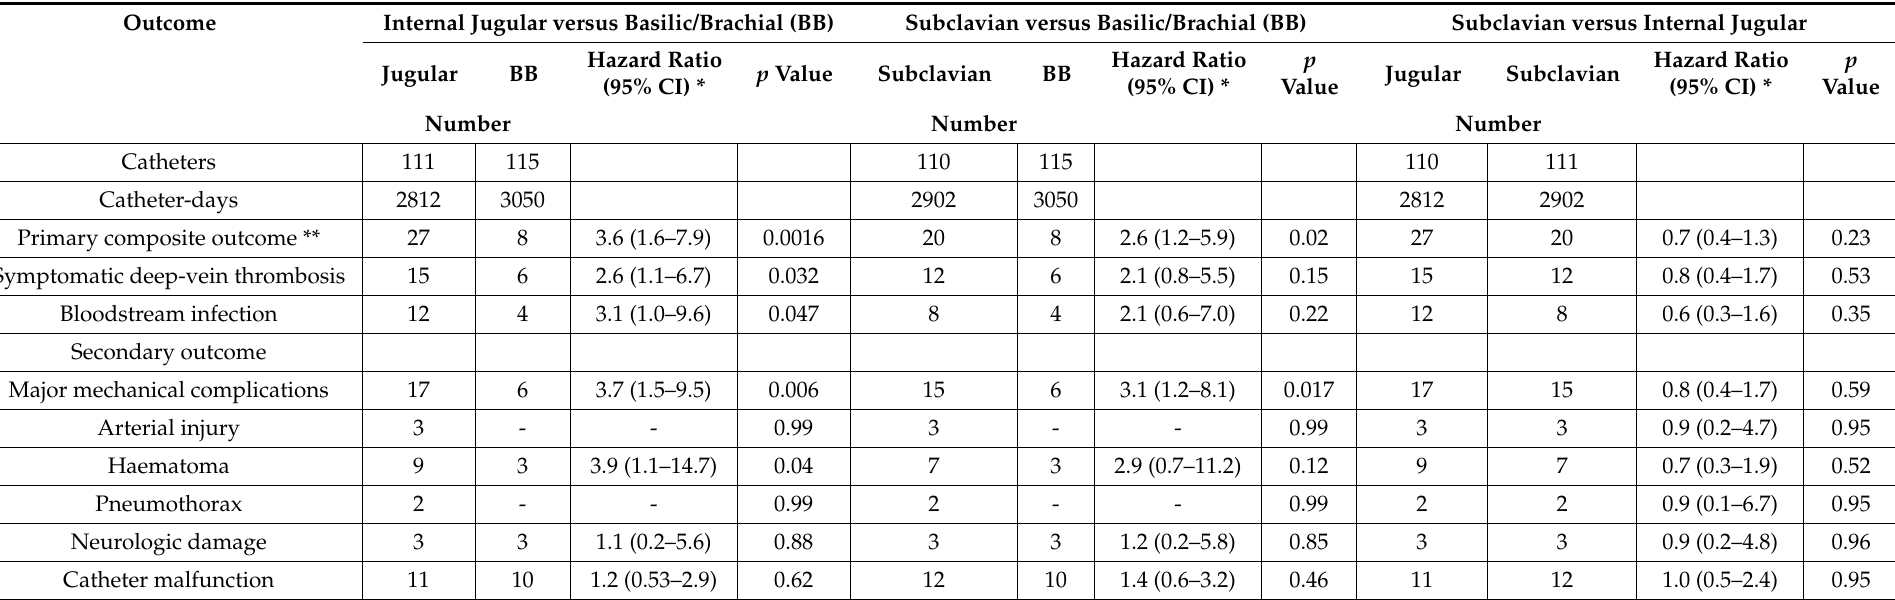
Table 3. Pairwise comparisons for the Trial